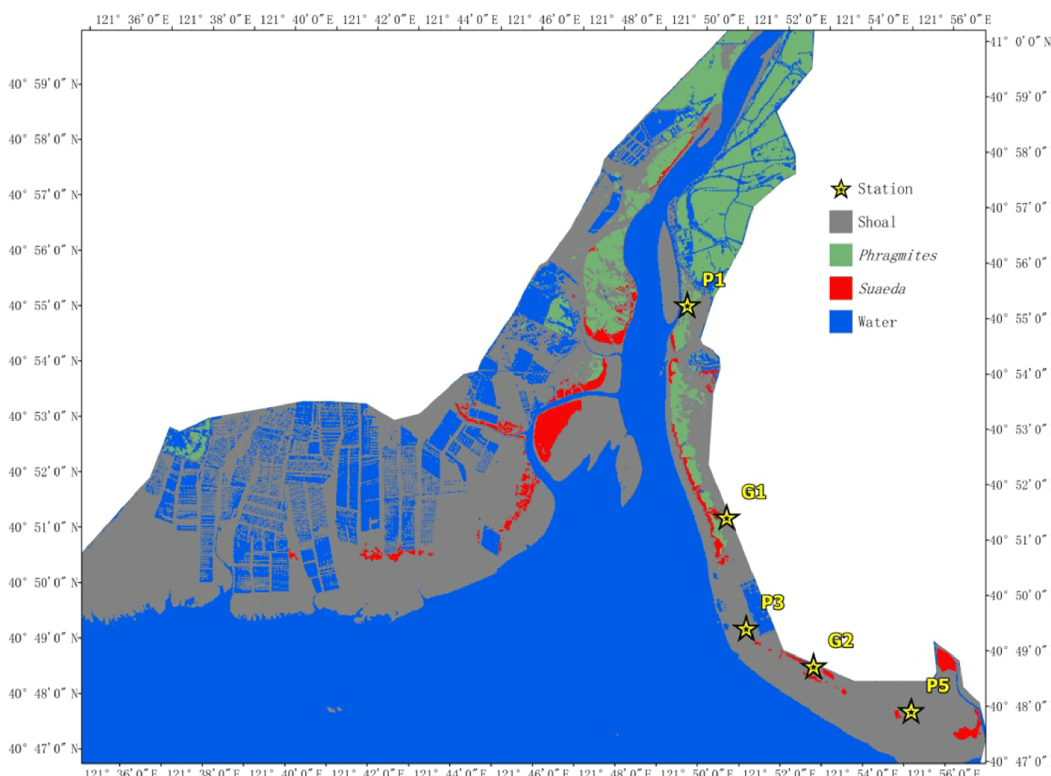
Figure 11. The distribution of the aquatic plants and selected stations at Pink Beach wetlands.